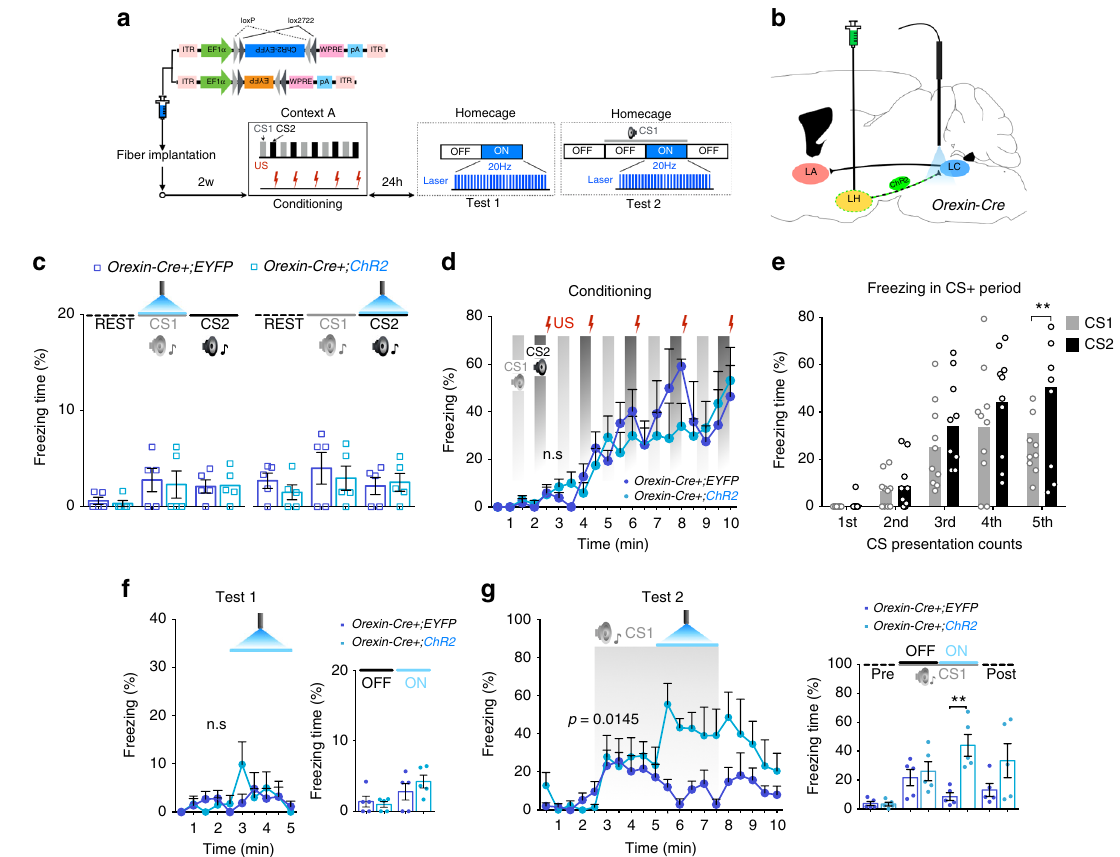
Fig. 8 Optogenetic simulation of orexin LH → LC pathway potentiates CS-triggered fear expression and generalization. a Experimental procedure. b Schematic representation showing sites of AAV-EF1 α -FLEX (loxP)-ChR2-EYFP and AAV-EF1 α -FLEX (loxP)-EYFP delivery and optic fi ber implantation. c Before conditioning, CS1(white noise) or CS2 (tone), even coupled with optogenetic stimulation of orexin LH → LC fi bers did not affect freezing response. d , e In cued fear conditioning session, although freezing time was gradually increased, different type of CS (CS1, CS2 paired with US) showed differential effects on freezing. f Twenty-four hours after fear conditioning, optogenetic stimulation of orexin LH → LC pathway in homecage did not show any freezing response in contrast with that observed in context A ′ (Fig. 5e). g We performed optogenetic stimulation with CS1 in homecage. During the presentation of CS1, optogenetic stimulation of orexin LH → LC pathway strongly potentiated freezing behavior induced by CS1 as compared to control group. * p < 0.05, ** p < 0.01. Values are mean ± post-hoc test, F (1, 11) = 14.30, p = 0.0030, Fig. 6e, left, Movie Figs. 2 and 3; average freezing: unpaired two-tailed Student ’ s t test, t = 5.279, p = 0.0004, Fig. 6e, right). Although we did not monitor fi ring rate of NA LC neurons in fearful condition, Takeuchi et al reported that these neurons showed burst fi ring at ranging from 15.3 to 28.2 Hz when the mice were put into the novel cage, although basal fi ring rate is 0.23 – 6.03 Hz 25 . Based on this observation, we here used pulses of 473 nm illumination at 20 Hz (pulse width = 35 ms, interval = 15 ms, 10 mW) for the photostimulation. Again, we did not see a photostimulation- induced freezing response in context A ′ without prior fear con- ditioning in context A ( NAT-Cre-;ChR2 (not conditioned), n = 6; NAT - Cre + ;ChR2 (not conditioned), n = 6: one-way ANOVA with Tukey ’ s post-hoc test, F (7, 40) = 0.7440, p = 0.6364, Fig. 6f). After optical stimulation, we validated Fos-positive cells in the LA. Fos- positive cells were increased by optogenetic manipulation (WT (control), n = 4; WT (CS+), n = 3; NAT-Cre-;ChR2 , n = 3; NAT - Cre + ;ChR2 , n = 4: one-way ANOVA with Sidak ’ s post-hoc test, F (3, 10) = 10.66, p = 0.0019, Fig. 6g, h), suggesting that the nora- drenergic in fl uence on LA neurons is excitatory. When optic fi bers were not precisely implanted at the LA, photostimulation did not evoke any effect in the conditioning and test sessions (Supplementary Fig. 6).